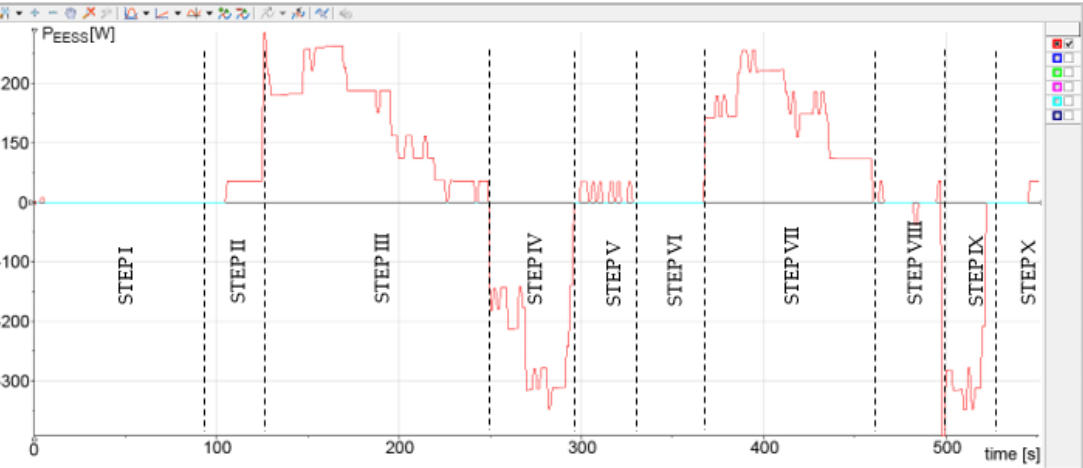
Figure 10. RMS AC voltage of PEI converter.